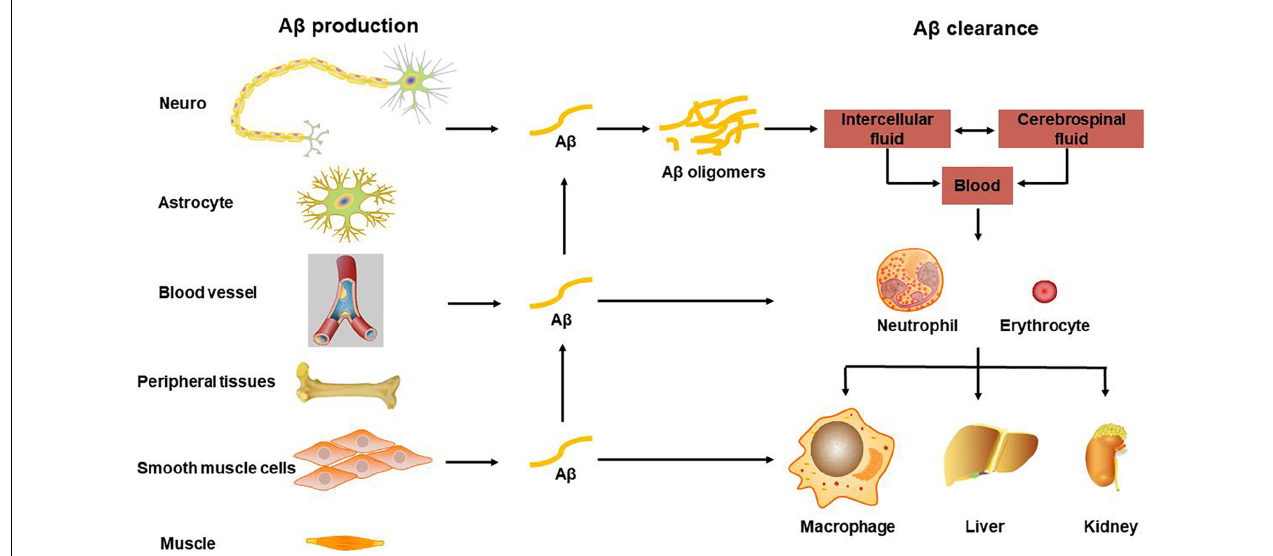
FIGURE 1 | Transport and clearance of A β in brain and peripheral tissues and organs. A β is produced by neurons and glial cells in the brain, as well as peripheral blood vessel wall cells, skeletal muscle, and osteoblasts, etc., and secreted out of the cell; A β in the central nervous system is transported through brain tissue fluid, cerebrospinal fluid, and blood-brain barrier to the peripheral blood; monocytes and neutrophils swallow part of A β , some are degraded by A β degrading enzymes, and the other part is swallowed by macrophages in peripheral organs and tissues, or is excreted through bile and